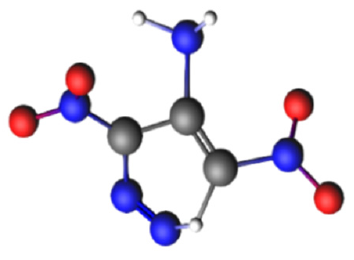
Figure 7. Hydrogen transfer triggers the ring opening of LLM-116.